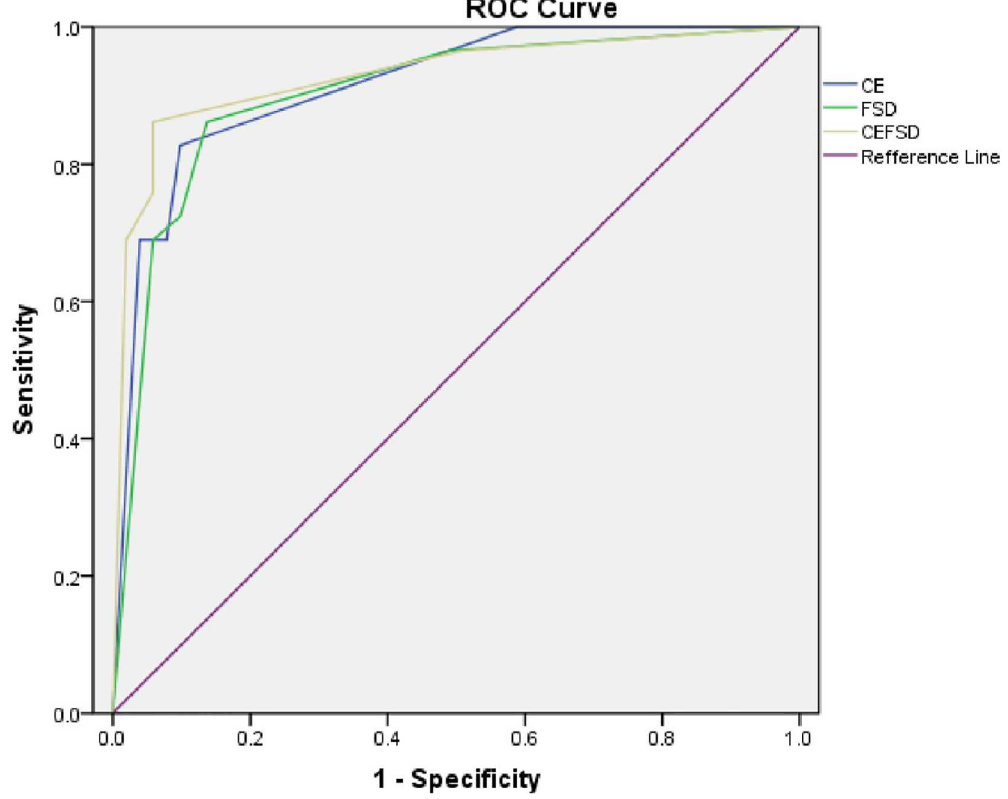
Fig 4. ROC curves of stenosis degree detection in FSD-MRA, CE-MRA, and CE+FSD-MRA with DSA as the standard reference. The area under the curve was largest for CE+FSD MRA (yellow, 0.929, p < 0.01), and was slightly larger for CE-MRA (blue, 0.915, p < 0.01) than for FSD-MRA (green, 0.903, p <